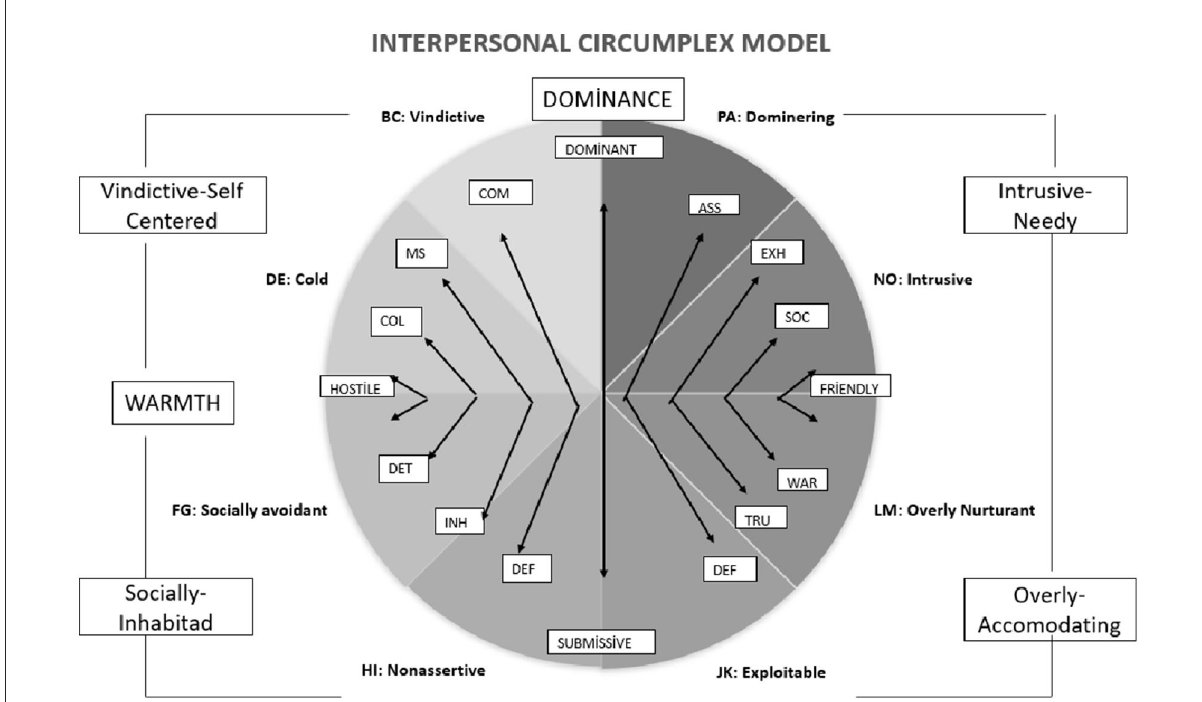
FIGURE1 Completion pattern of Kiesler’s (1983) interpersonal circumplex model of personality. According to the principle of completion in interpersonal relationships, it enables the emergence of anti-behavior behaviors close to the dimension of dominance-submissive; behaviors close to the size of friendly-hostile lead to the emergence of reactions that will complement them. The polar loop is the interpersonal loop proposed by Kiesler (1983). It forms the basis of the principle of completion of interpersonal relationship patterns. According to the complementarity principle, behaviors in the control dimension lead to the opposite behaviors (e.g., dominant-passive), while behaviors in the coexistence dimension lead to the emergence of reactions from their own class that will complement them (e.g., hostile-hostile, friendly-friendly). The interpersonal circumplex (IPC) model classified interpersonal schema and behaviors into eight octants under orthogonal two axes (Dominance and Warmth). Each octant was described as Domineering (PA), Vindictive (BC), Cold (DE), Socially avoidant (FG), Non-assertive (HI), Exploitable (JK), Overly Nurturant (LM), and Intrusive (NO) characteristics (Horowitz, 2004; Gurtman,